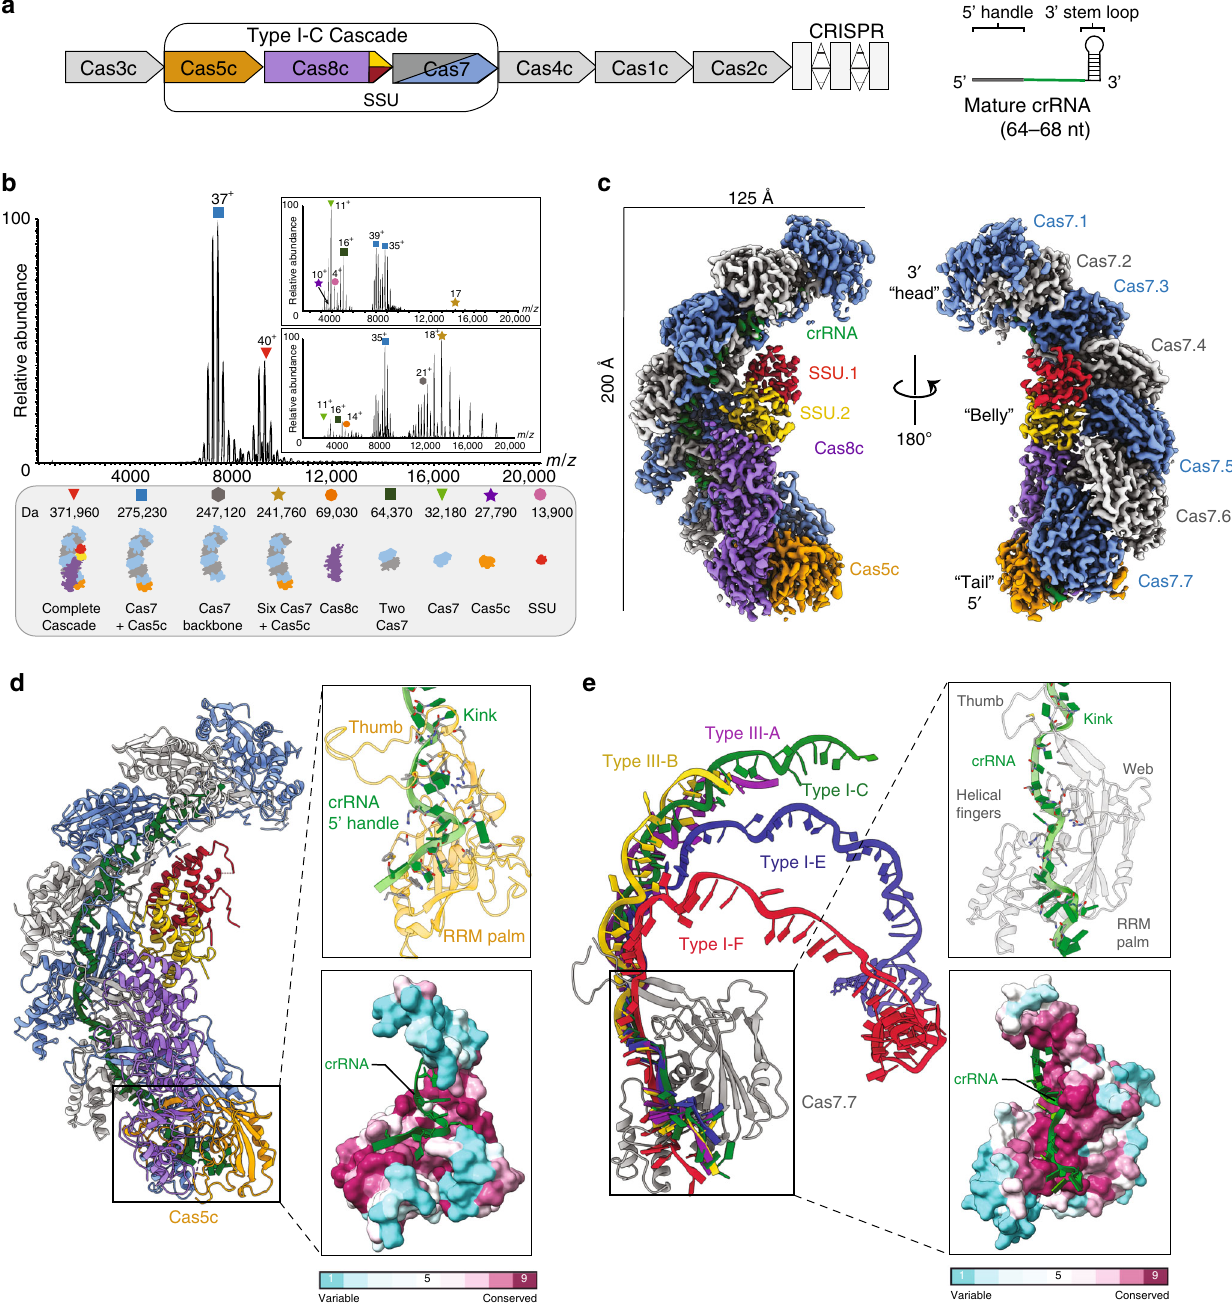
Fig. 1 Architecture of type I-C Cascade. a The D. vulgaris type I-C operon (left) and mature crRNA (right). b ESI mass spectrum of the type I-C Cascade con fi rms the presence of a non-canonical SSU. Gentle disassembly of the complexes prior to mass analysis using two different desolvation voltages ( − 120 and − 300 V) allows the composition of the individual subunits and the architecture of the complexes to be determined (inset top and bottom). All complexes/subcomplexes detected and associated experimental masses are annotated. c Cryo-EM structure of the type I-C Cascade at 3.1-Å resolution. The structure is segmented and colored as follows: Cas7, blue and gray; Cas8c, purple; Cas5, orange; Cas11c, gold and red; crRNA, green. d The resulting atomic model colored as in c . Cas5c (orange) resembles a right-handed fi st with an RRM palm and thumb domains. Residues (gray) interacting with the 5 ′ - handle (green) (inset top) are highly conserved (inset bottom). e Alignment of type III-B (yellow), type I-E (blue), type I-F (red), type III-A (purple) Cas7 tail to type I-C Cas7.7 demonstrates variability in crRNA backbone orientation. Residues (dark gray) interacting with the crRNA (green) (inset top) are highly conserved (inset